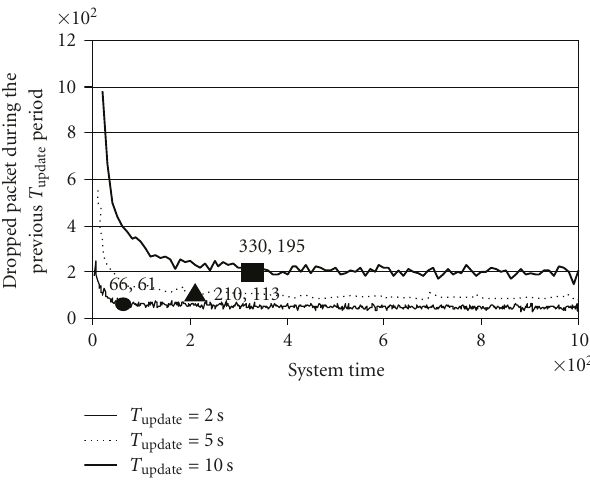
Figure 6: Dropped packets per T update for di ff erent T update values.